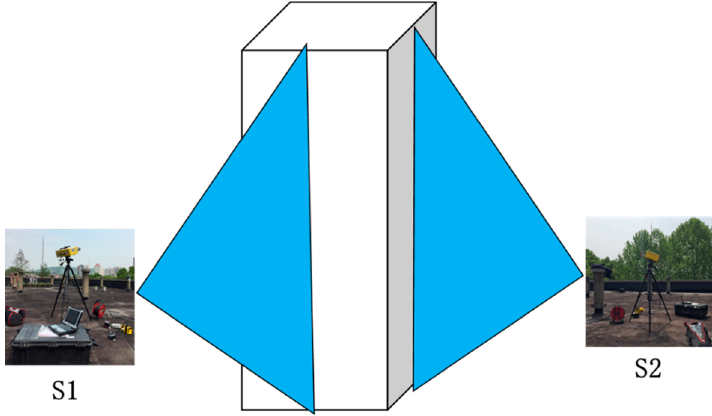
Figure 2. Schematic of ground-based real aperture radar (GB-RAR) working base points.